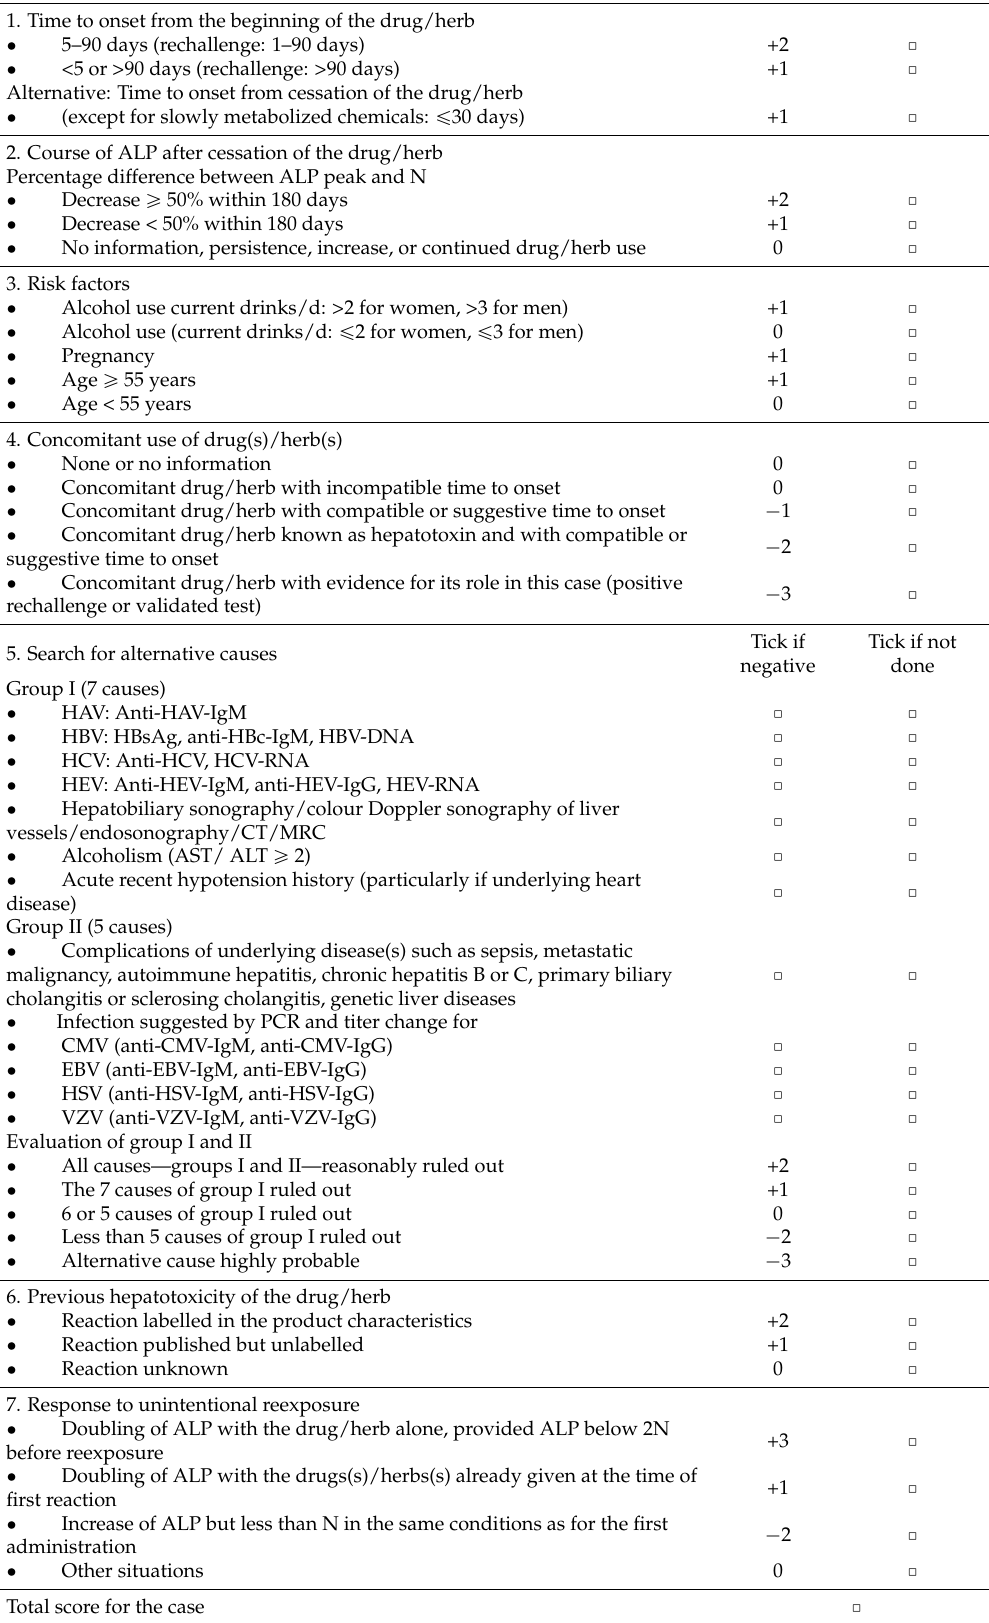
Table 3. Updated RUCAM for the cholestatic or mixed liver injury of DILI and HILI. Items for Cholestatic or Mixed Liver Injury Score